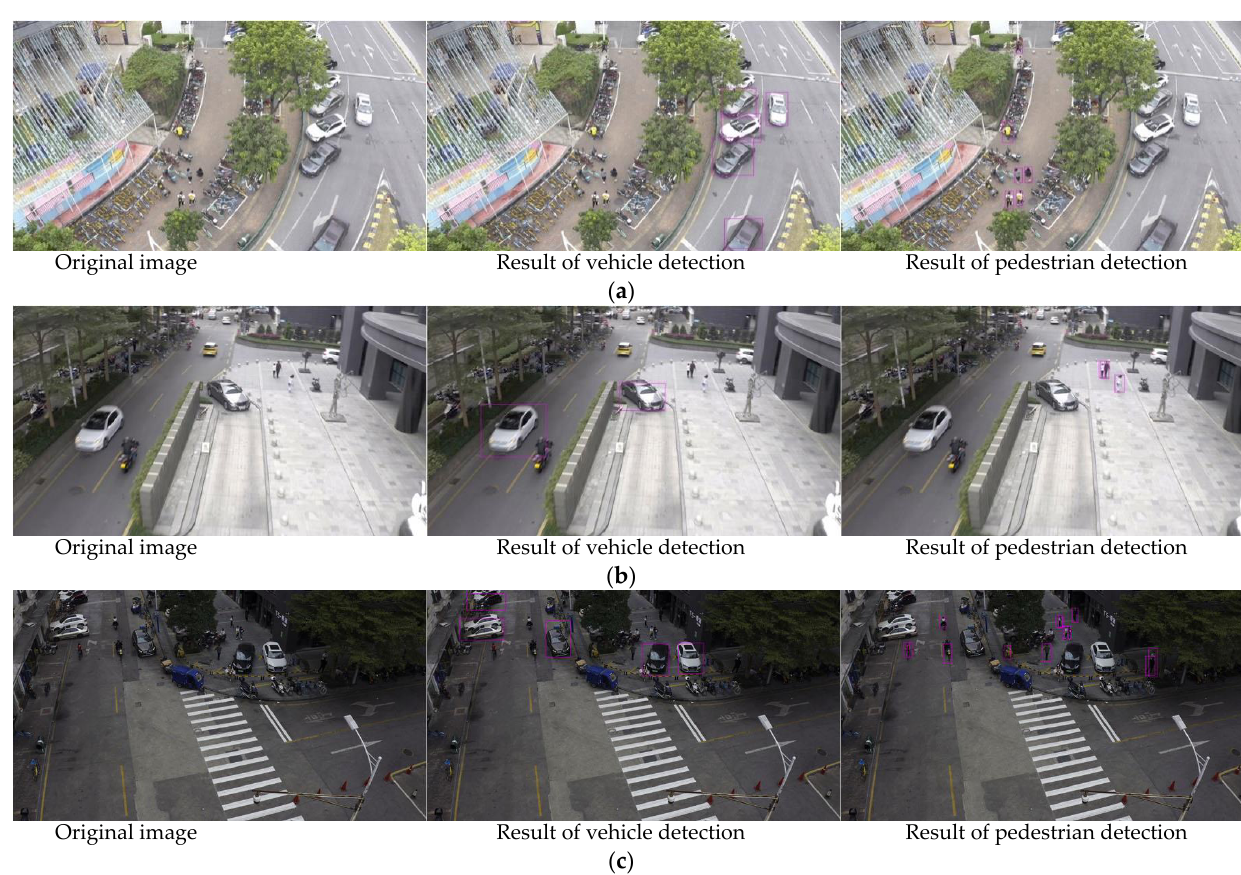
Figure 6. Ground vehicle and pedestrian detection results of our proposed method using images with different scenes and environment luminance. ( a ) Image and detection results under excellent imaging luminance. ( b ) Image and detection results under ordinary imaging luminance. ( c ) Image and detection results under severe imaging luminance.